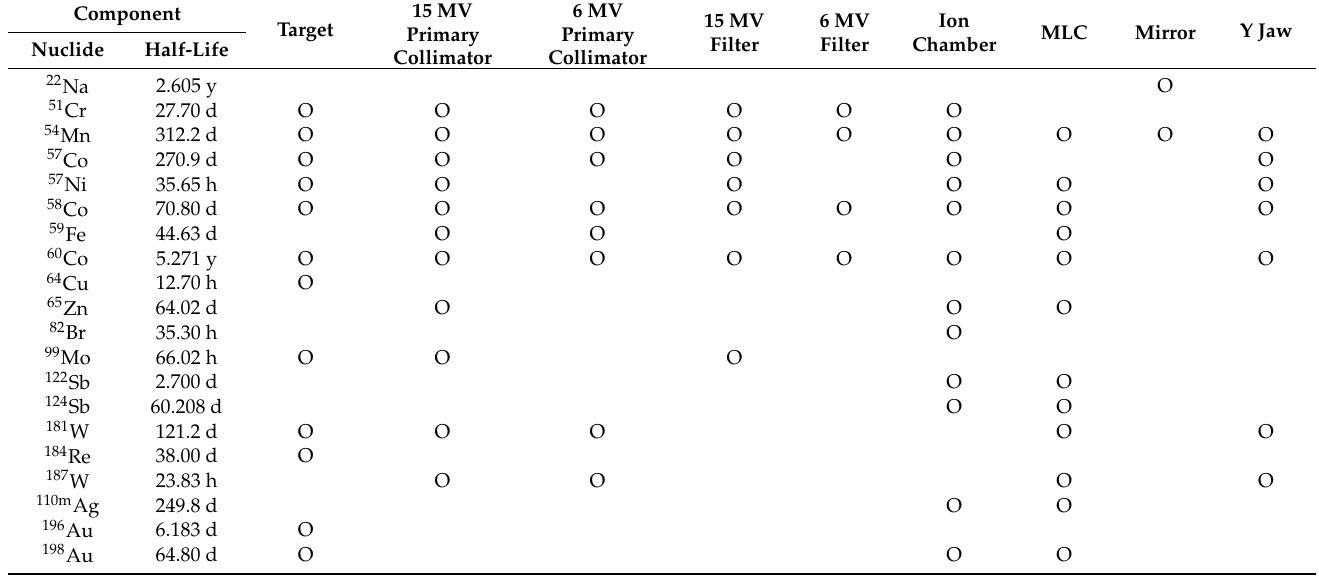
Table 5. Radionuclides per components detected by